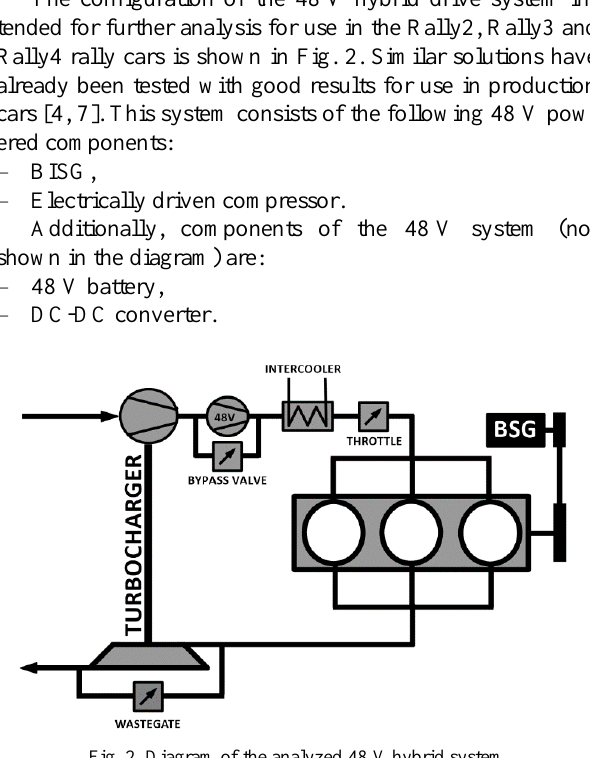
Fig. 2. Diagram of the analyzed 48 V hybrid